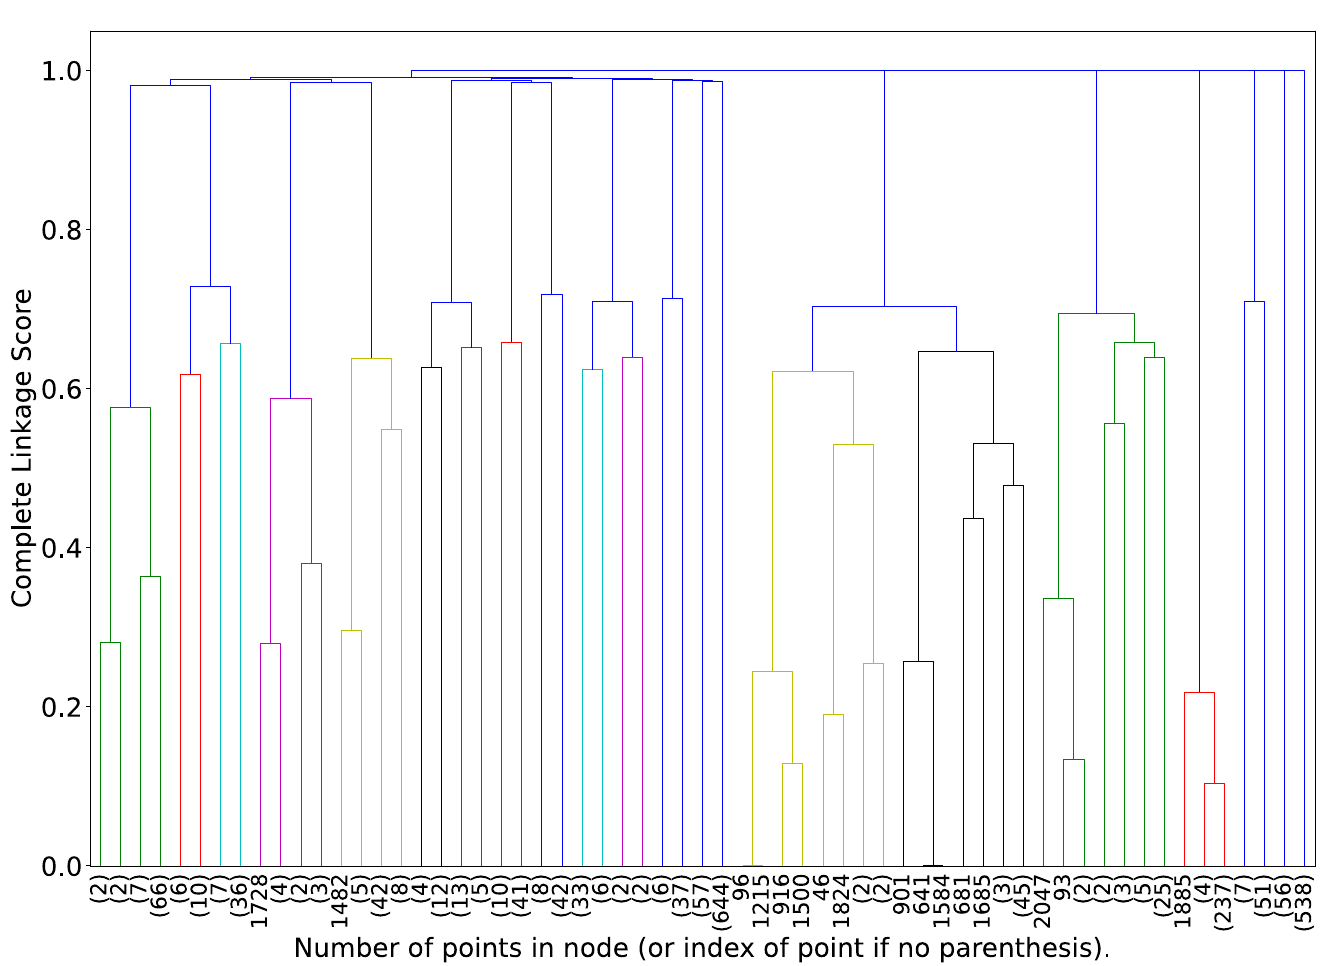
Fig 9. Illustrating the partial dendrogram obtained from agglomerative hierarchical clustering and representing different clusters upto 5 levels from root.